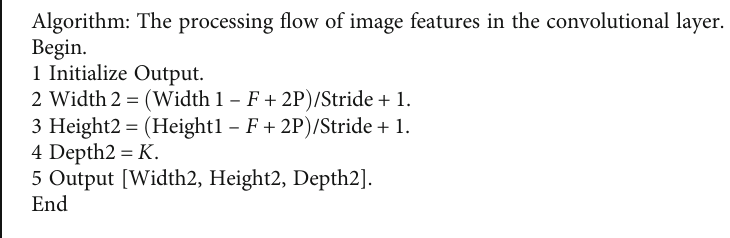
Algorithm: The processing fl ow of image features in the convolutional layer.